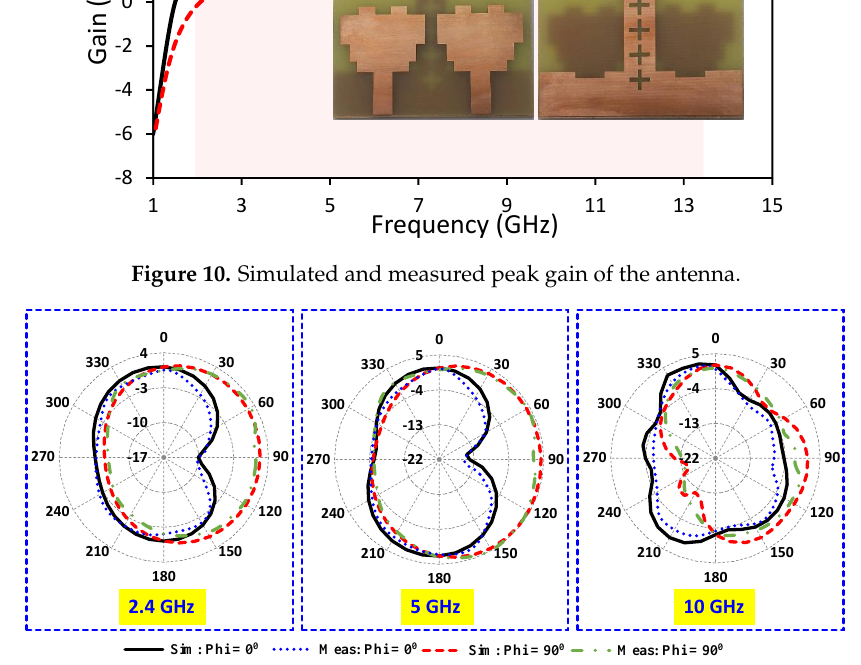
Figure 11. Radiation pattern of the antenna at 2.4, 5 and 10